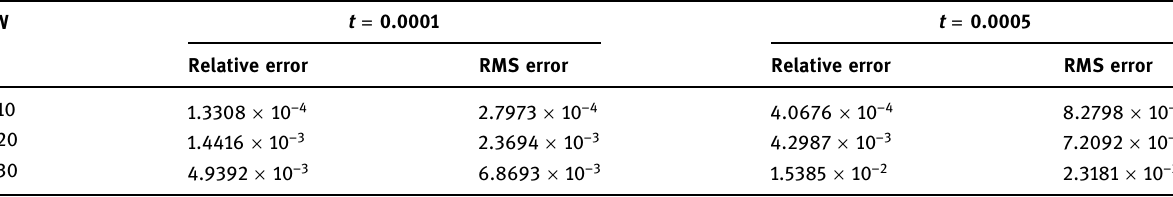
Table 12: Relative and RMS errors at = t 0.0001 and = t 0.0005 , respectively,